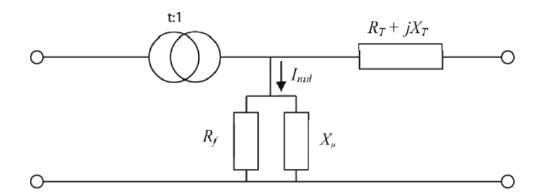
Figure 2. A schematic representation of the transformer model. The transformer is modeled as an RL network